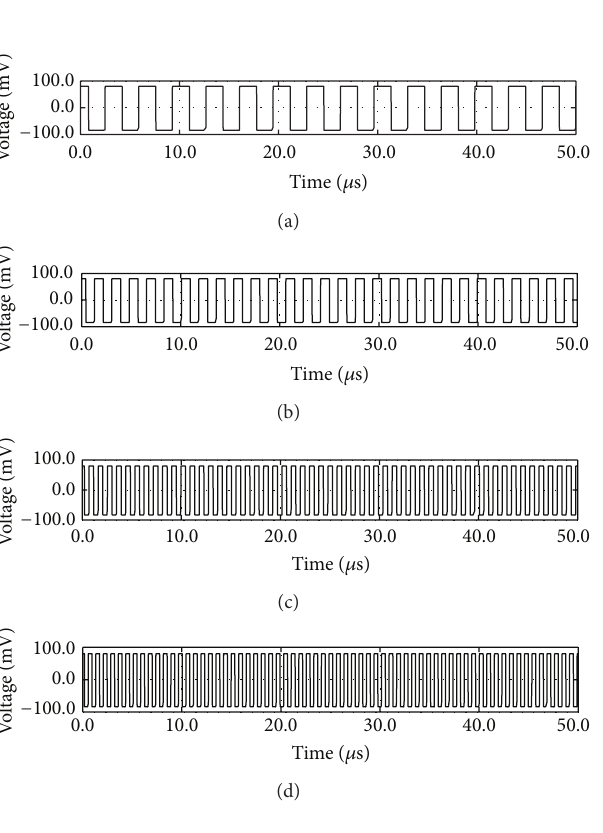
= 20 𝜇 A and 𝐼 = (a) 10 𝜇 A, Bias 2 Bias 1